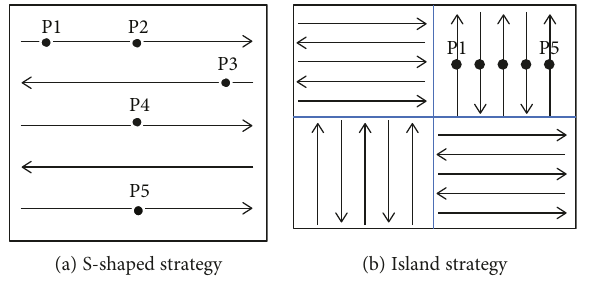
Figure 5: Laser scanning